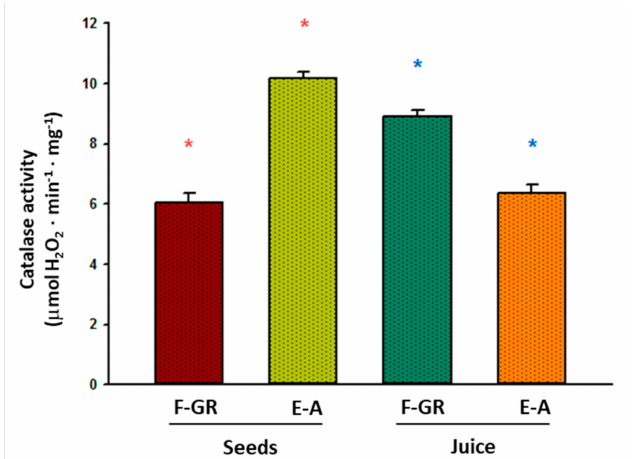
Figure 3. Catalase activity in seeds and juice from two Spanish pomegranate populations. Pomegranate fruits from El Fargue, Granada (F-GR) and Elche, Alicante (E-A) were analyzed. Colored asterisks depict significant di ff erences ( p < 0.05) between either seed (red) or juice (blue) samples according to the Student’s t -test.